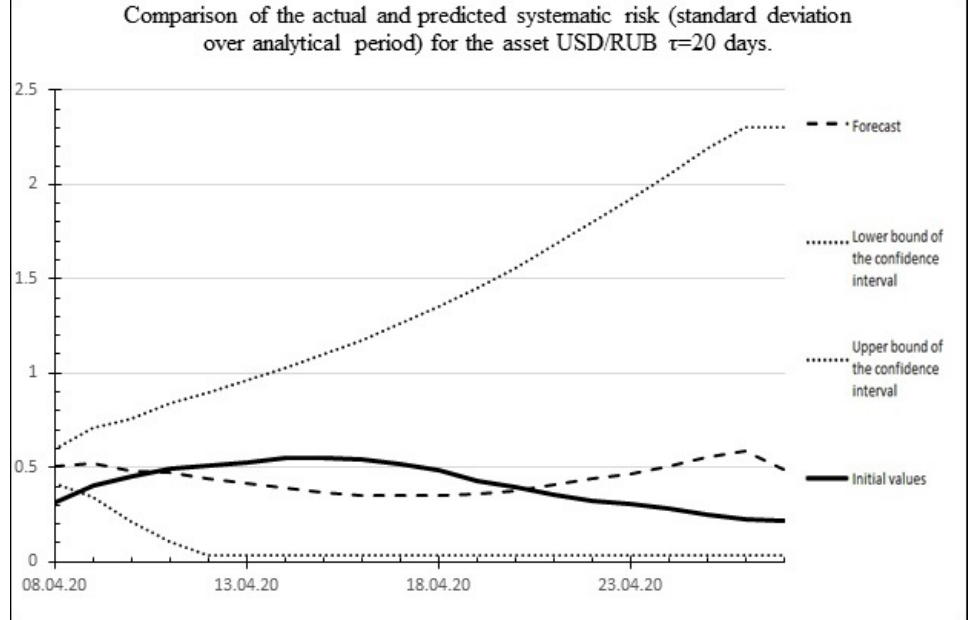
Figure 13. Comparison of the results of the 20 days ahead forecast of systematic risk of the USD/RUB asset with actual